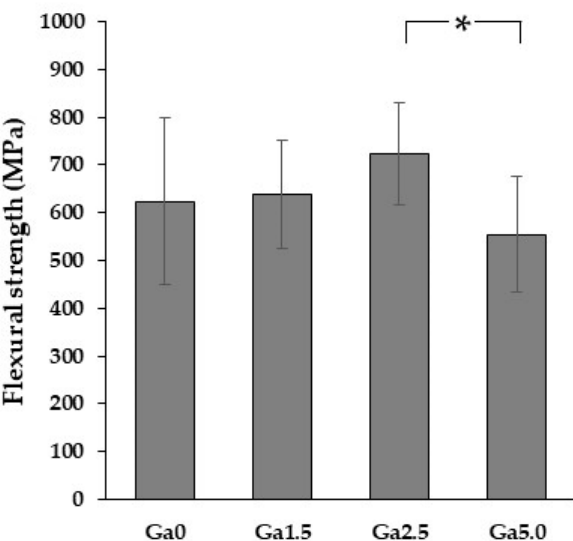
Figure 10. Flexural strength of each sample. The asterisk refers to statistical significance.